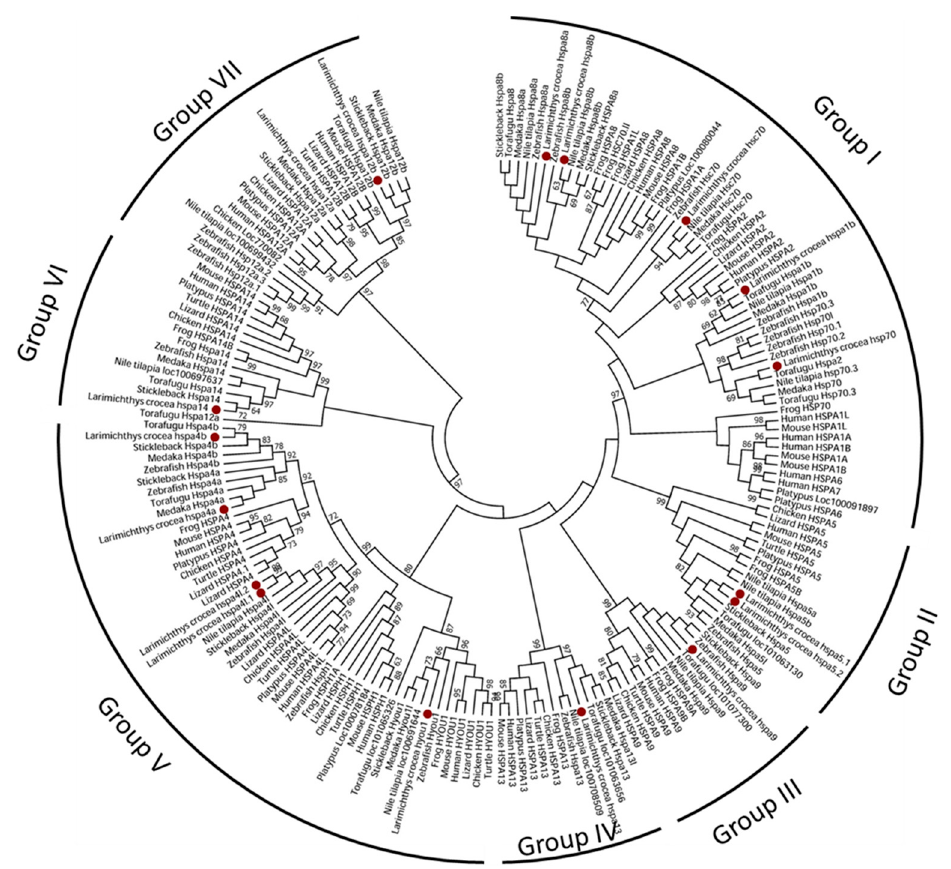
Figure 1. Phylogenetic tree of the heat shock protein 70 (Hsp70) family based on the maximum likelihood method. The bootstrap consensus tree inferred from 1000 replicates is taken.